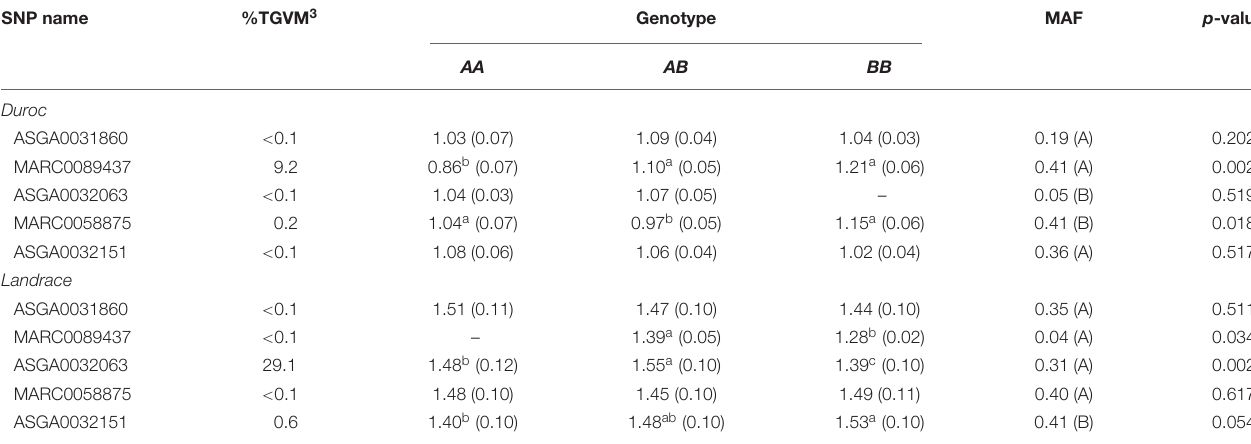
TABLE 2 | Effect 1 of selected SNPs 2 associated with sample-to-positive (S/P) ratio during the PRRS outbreak for each